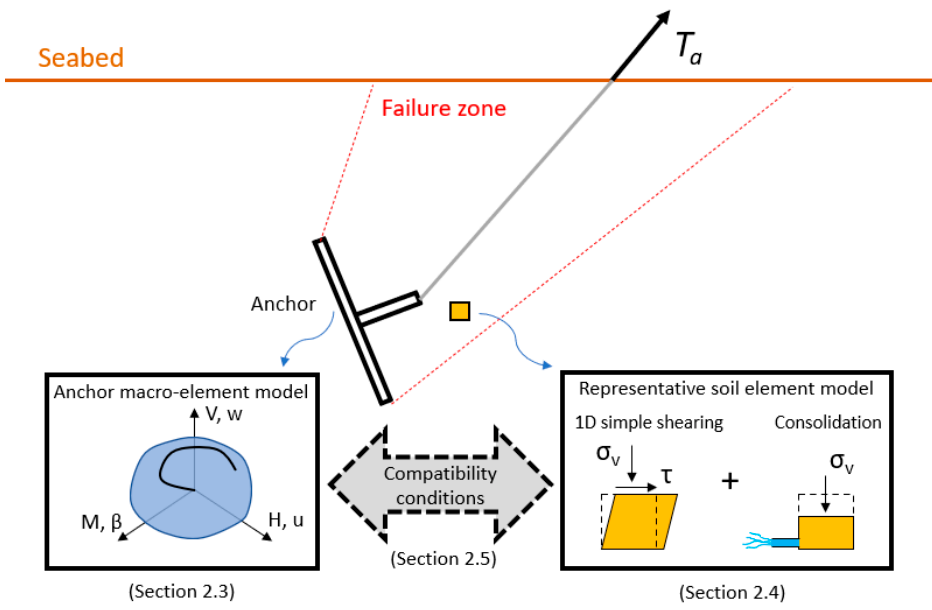
Figure 2. Relationship between the macro ‐ element model for the anchor and the soil constitutive model.